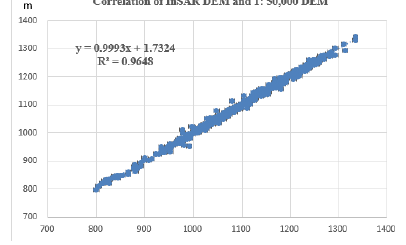
Figure 12. Correlation of InSAR DEM and 1: 50,000